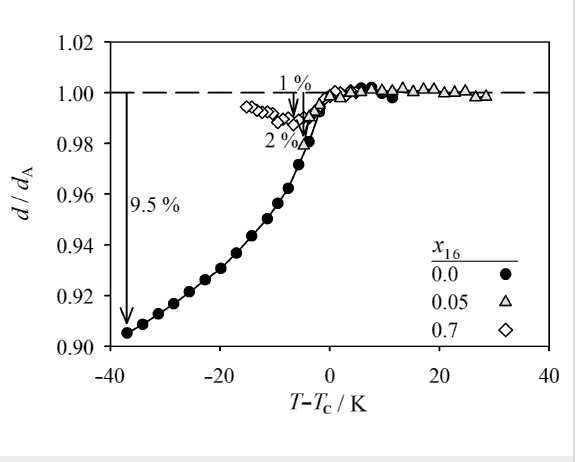
Figure 5: Reduced layer spacing d / d A versus temperature difference to the phase-transition temperature T − T c for pure 2PhP (closed circles) and the two mixtures that show SmA and SmC phases with x 16 = 0.05 (grey triangles) and 0.7 (open squares).